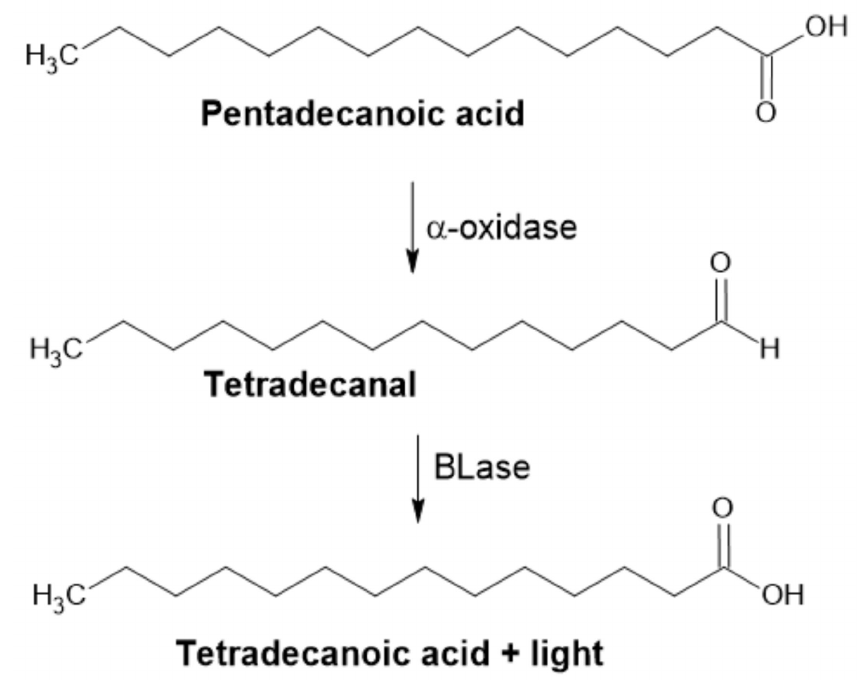
Figure 11. Application of BLase for detection of α -DOX activity.